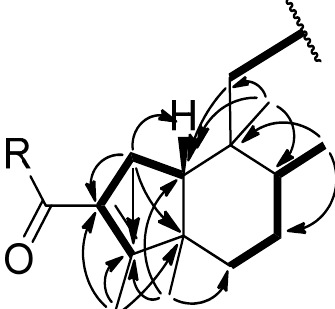
The main fragment of abeo -clerodanes 1 – 2 Figure 3. Selected NOESY correlations of compounds 1 – 2